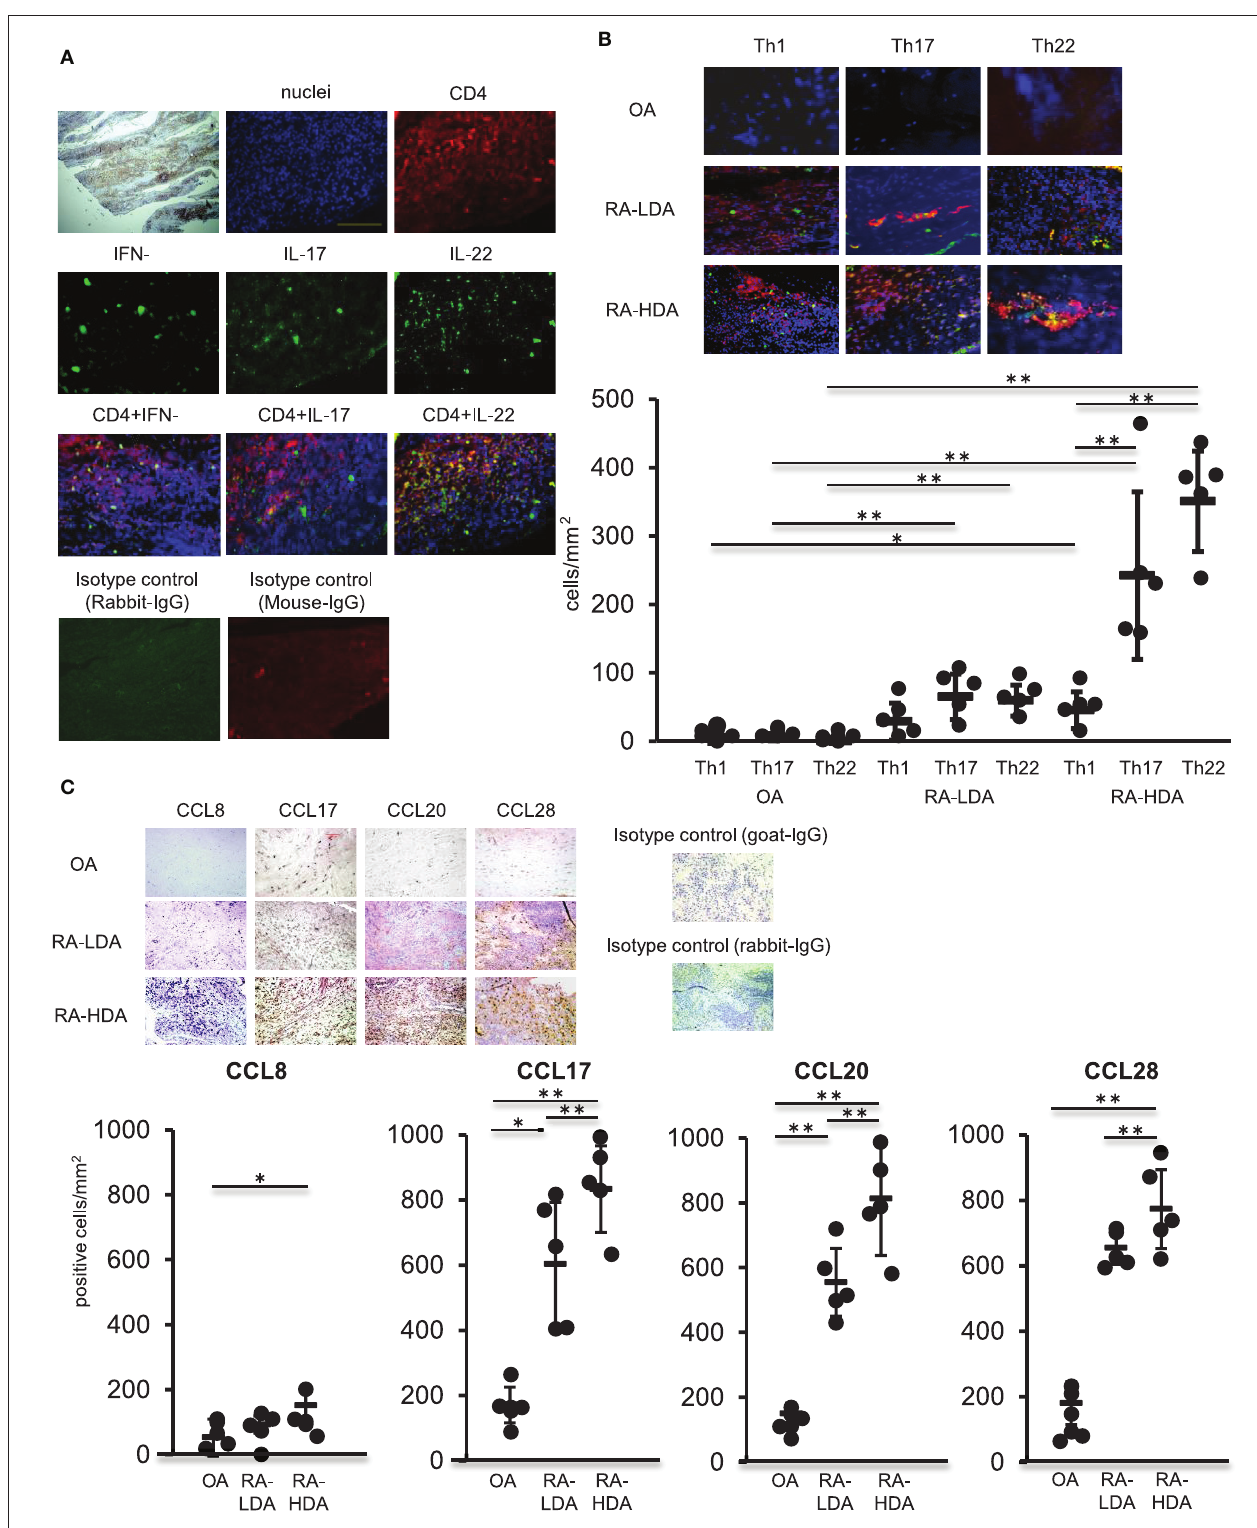
FIGURE 3 | Th22 cells accumulate in inflamed synovial tissues. (A) Dual-labeling immunofluorescence staining [anti-IFN- γ , anti-IL-17, anti-IL-22 (green), anti-CD4 antibody (red), and nuclei staining with DAPI (blue)] of synovial tissues from patients with active RA (magnification: 200 × ). (B) Immunohistologic localization of